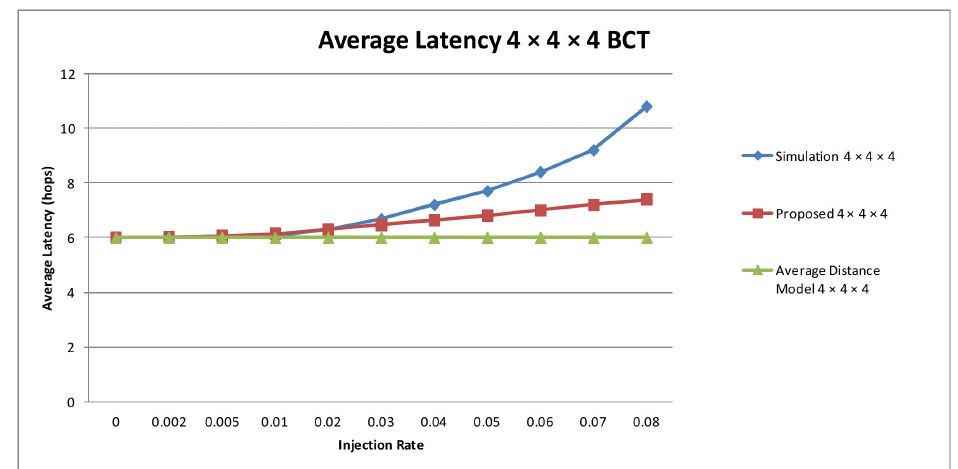
Figure 8. Average estimated latency vs. flit injection rate comparison between simulation, the proposed model and the average distance model for a 4 × 4 × 4 NoC topology and bit-complement traffic.